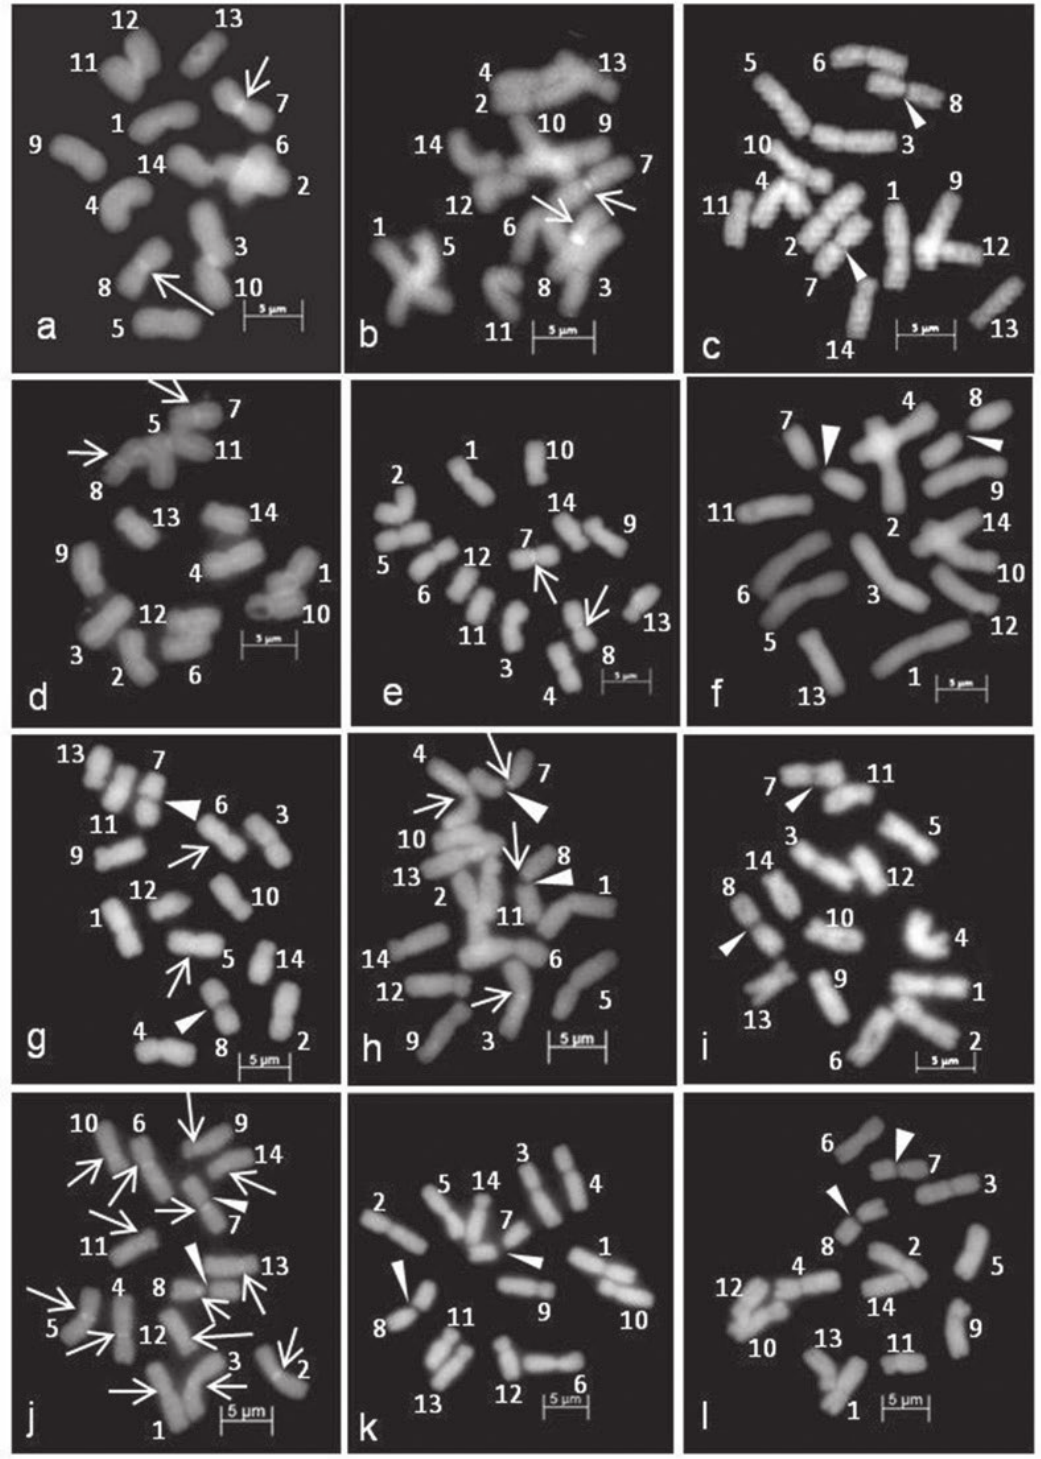
Figure 3. Somatic metaphase chromosomes of Lens culinaris cultivars. CMA stained plates: (a) Barasat Macro type, (b) PL-1406, (c) EC-70306, (d) EC -78410, (e) EC-78451-A, (f) EC-78473. DAPI stained plates: (g) Barasat Macro, (h) PL-1406, (i) EC-70306, (j) EC -78410, (k) EC-78451-A, (l) EC-78473. White arrows indicate CMA + or DAPI + bands and arrowheads indicate CMA 0 or DAPI 0 and DAPI - bands. Bars